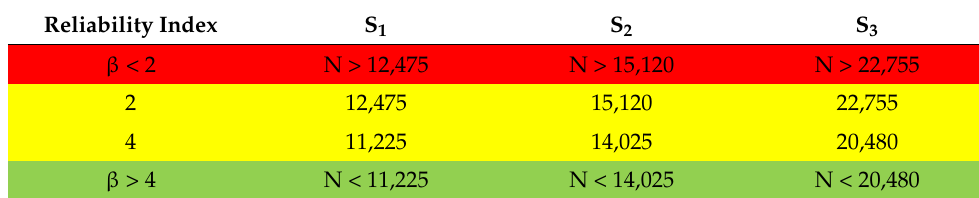
Table 4. Reliability-based performance assessment.